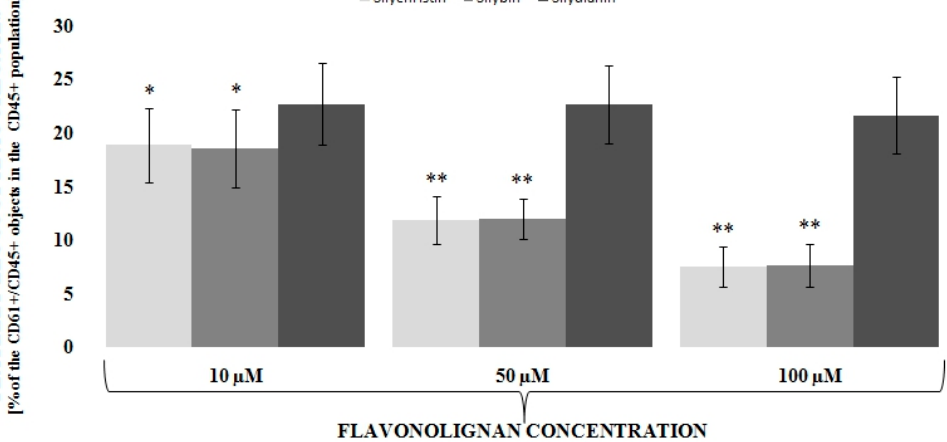
Figure 2. The effect flavonolignans; silychristin, silybin and silydianin in concentrations of 10, 50, and 100 µM on the IL-1 β (10 ng/mL) induced the formation of blood platelet-leukocyte aggregates. The results of double-label flow cytometry measurements are expressed as the amount of CD61+/CD45+ objects in the whole CD45+ population (presented as %), n = 12; * p < 0.01, ** p < 0.001.